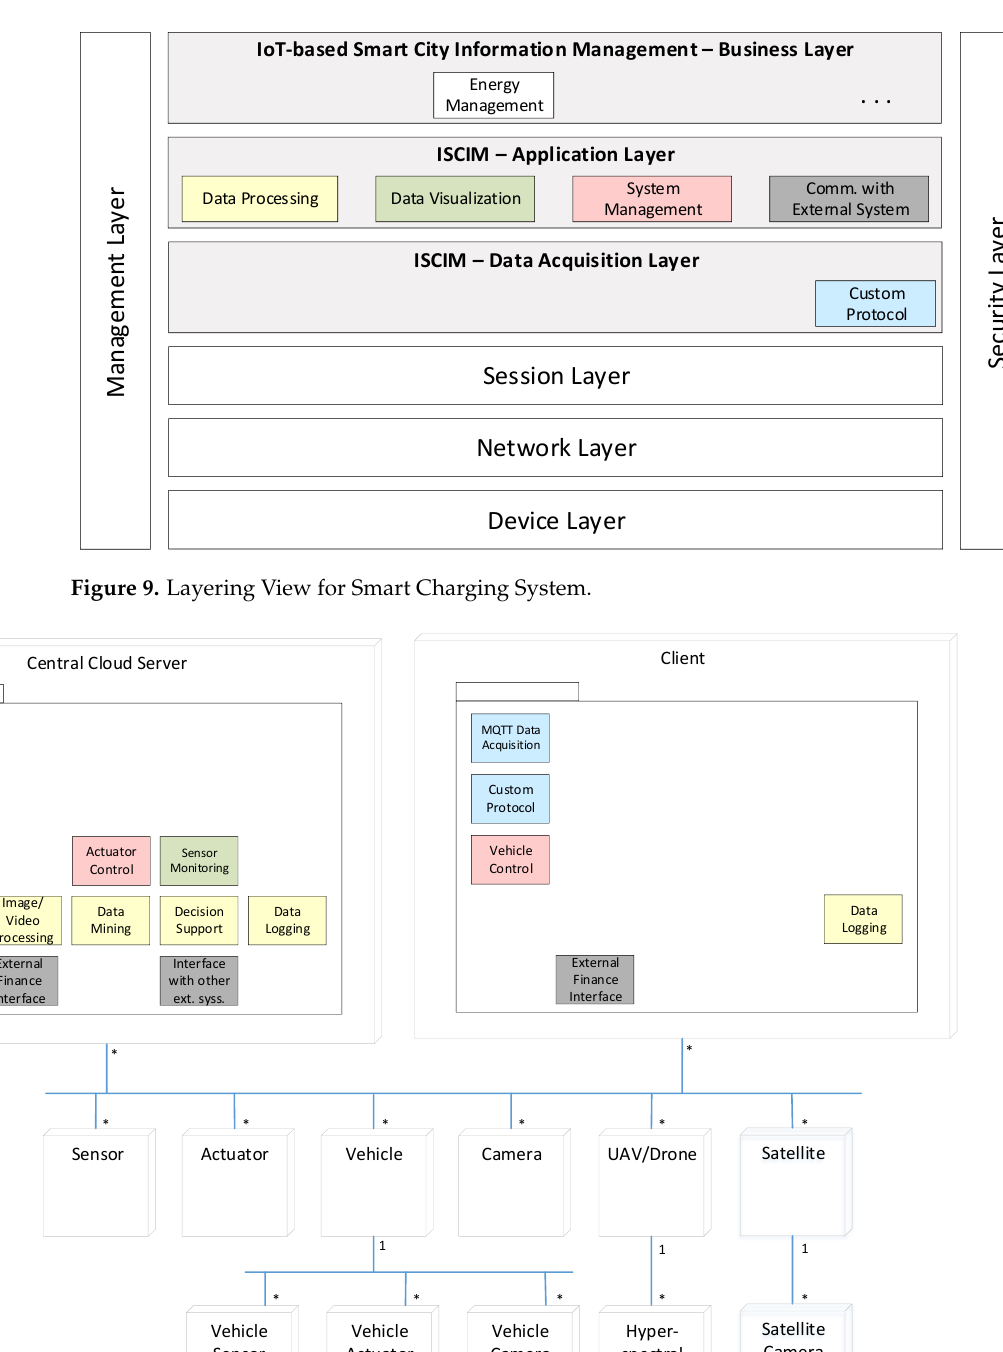
Figure 8. Decomposition View for Smart Charging System .